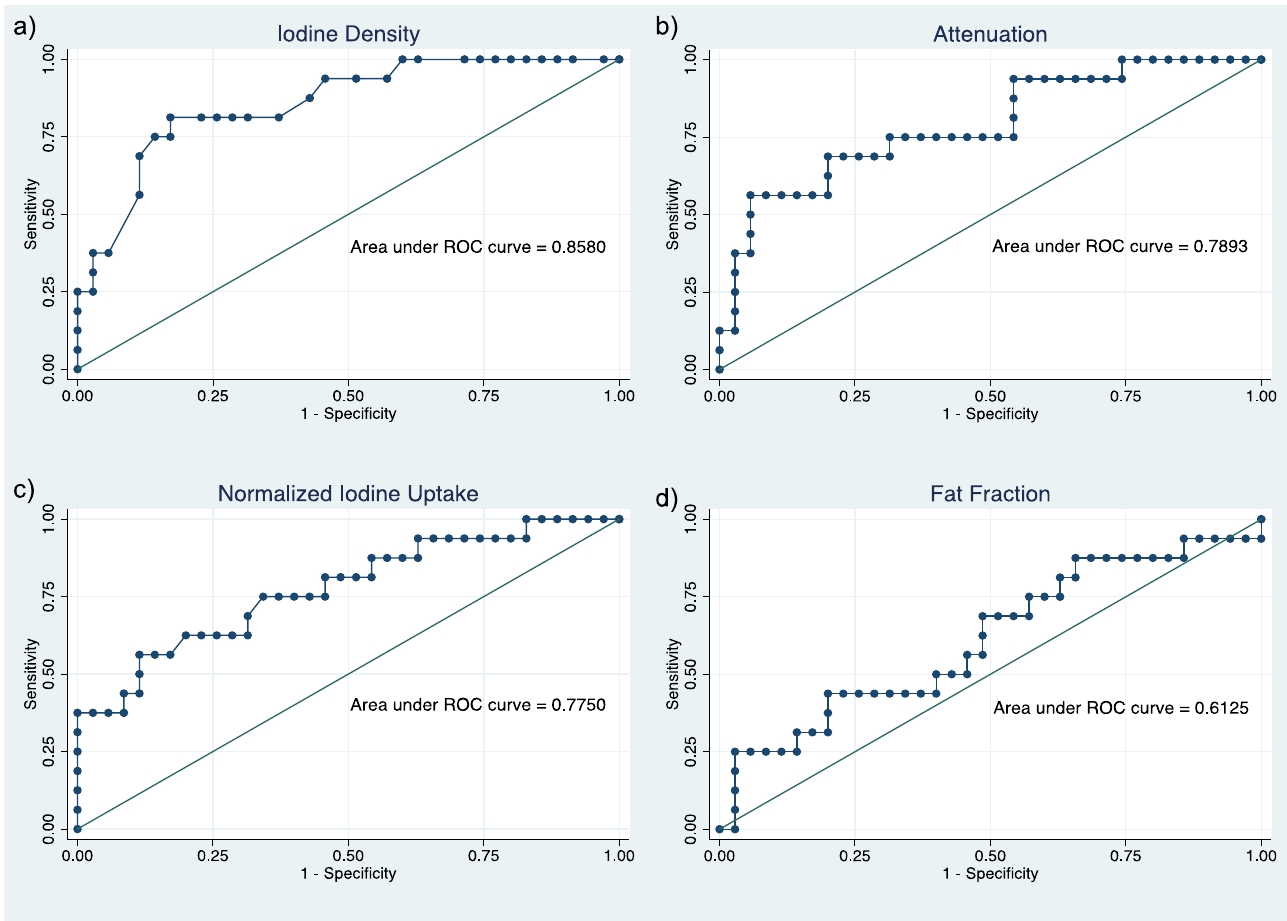
Figure 3. Receiver operating characteristic (ROC) curve analysis. Receiver operating characteristic (ROC) curve analysis for different quantitative image parameters. ( a ) Iodine density, ( b ) attenuation, ( c ) normalized iodine uptake, ( d ) fat fraction. Table 3. Correlation with acute pancreatitis severity and diagnostic performance to discriminate between mild/moderate acute pancreatitis and severe acute pancreatitis.